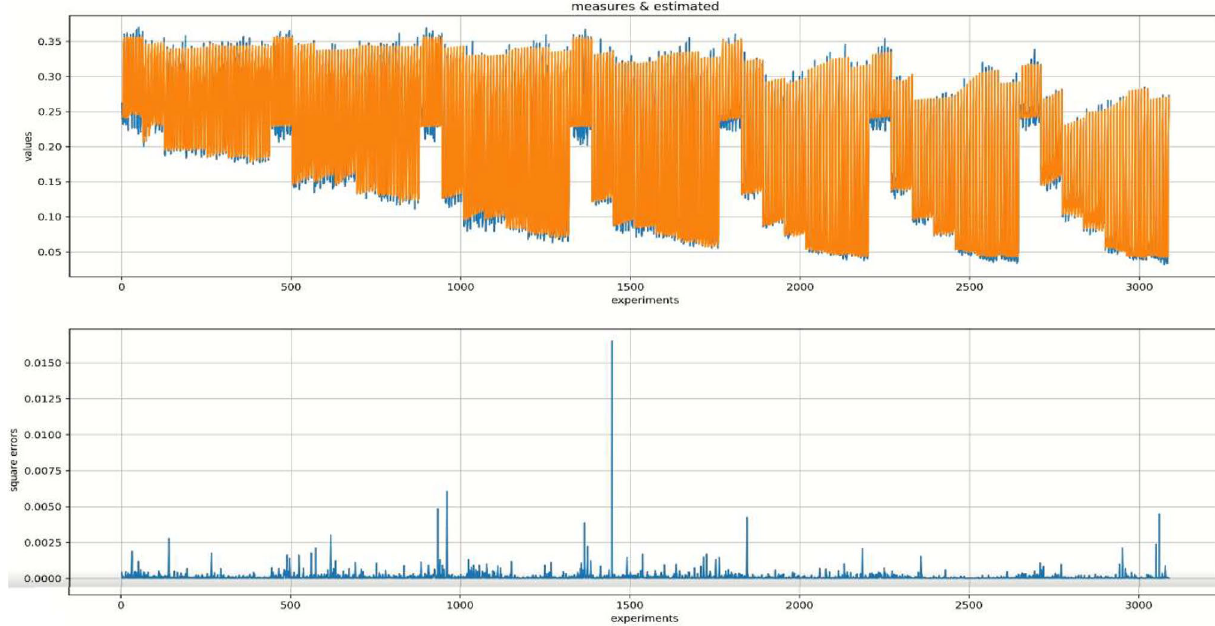
Figure 5. Illustration of data fit with the top panel showing the Euclidean distance values (i.e. the average error produced by the network) observed from the RNN model in blue and estimated by the MLP model in orange with time t . The second panel shows the paired square errors